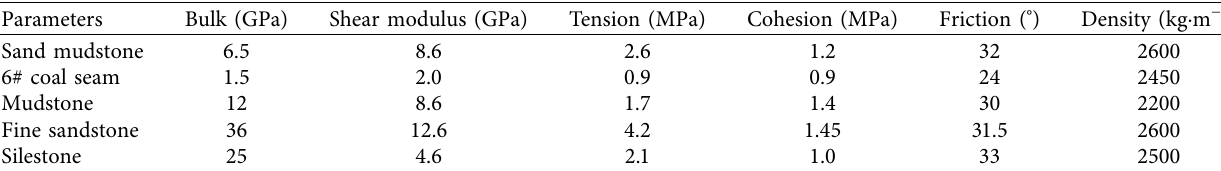
Figure 5: 3DEC numerical Table 1: The mechanical properties of the rock mass.